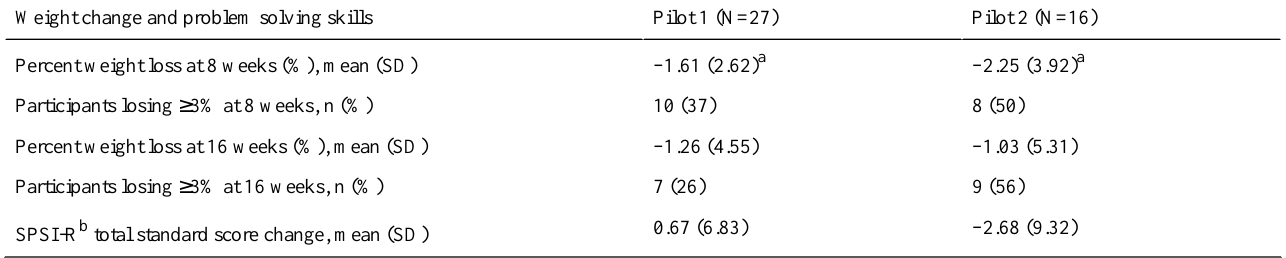
Table 4. Weight change and problem-solving skills in pilots 1 and